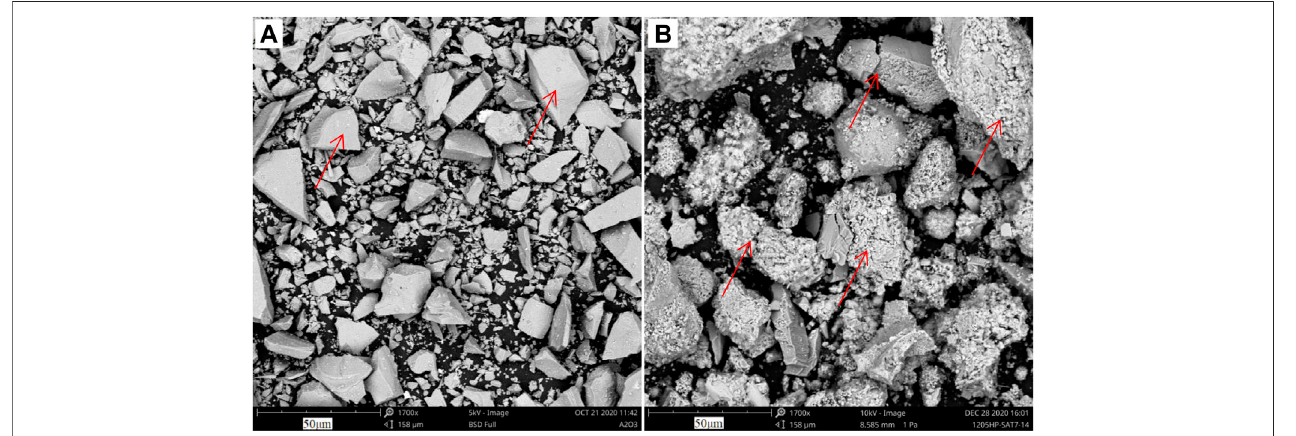
FIGURE 5 | SEM images of cement powder (A) and BDD samples (B) .